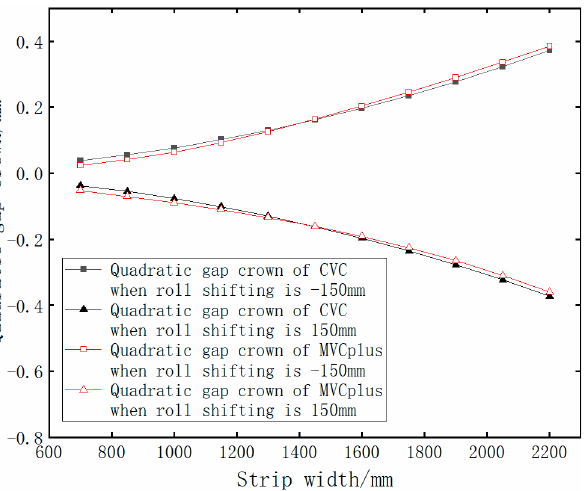
Figure 12. Adjustment ability of quadratic gap crown of MVCplus for strips with different widths.